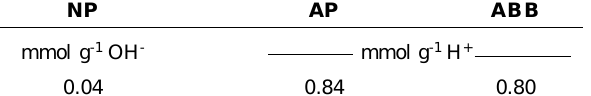
Table 3. Neutralization potential (NP), acidification potential (AP) and acid-base balance (ABB) of the waste material from uranium mine